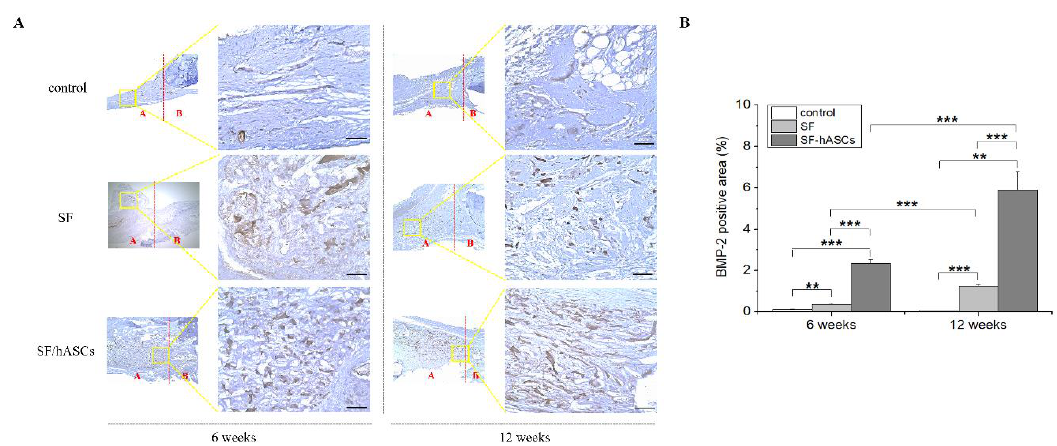
Figure 7. Bone morphogenetic protein-2 (BMP-2) immunohistochemical (IHC) staining of rat calvarial defects in the control, implanted SF scaffold, and implanted SF-hASCs scaffold groups. ( A ) IHC staining of BMP-2 positive cells, at six and twelve weeks postimplantation in three different groups. ( B ) Semi-quantitative analysis of the relative amounts of BMP-2-positive cells in three different groups (**, p ≤ 0.01; ***, p ≤ 0.001; scale bar = 50 μm; red A and B = defect area and host bone area, respectively).